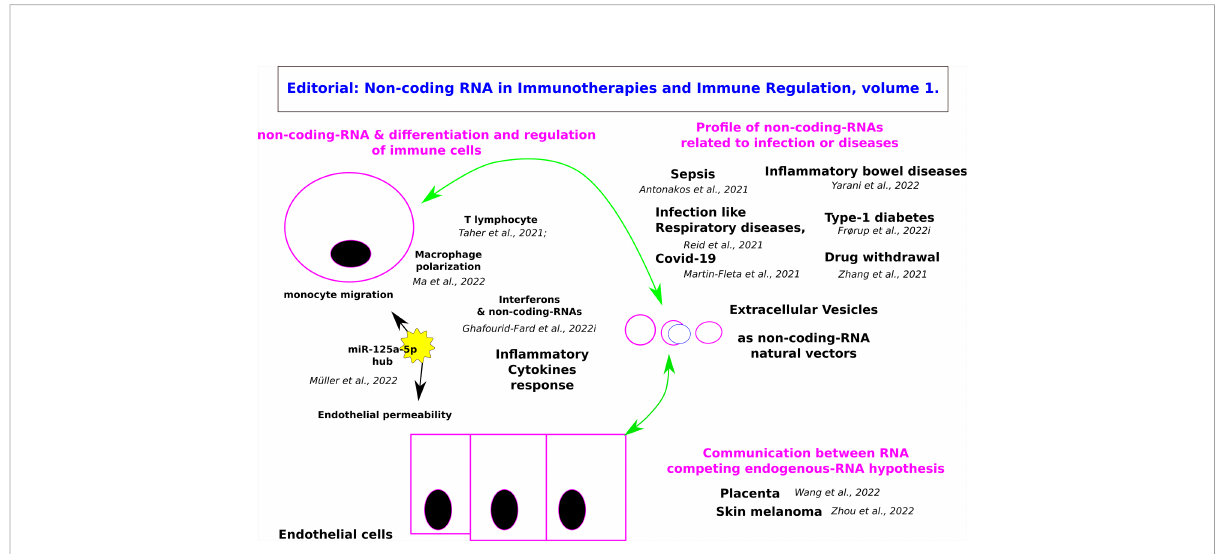
FIGURE 1 Graphical abstract of the Editorial: Non-coding RNA in Immunotherapies and Immune